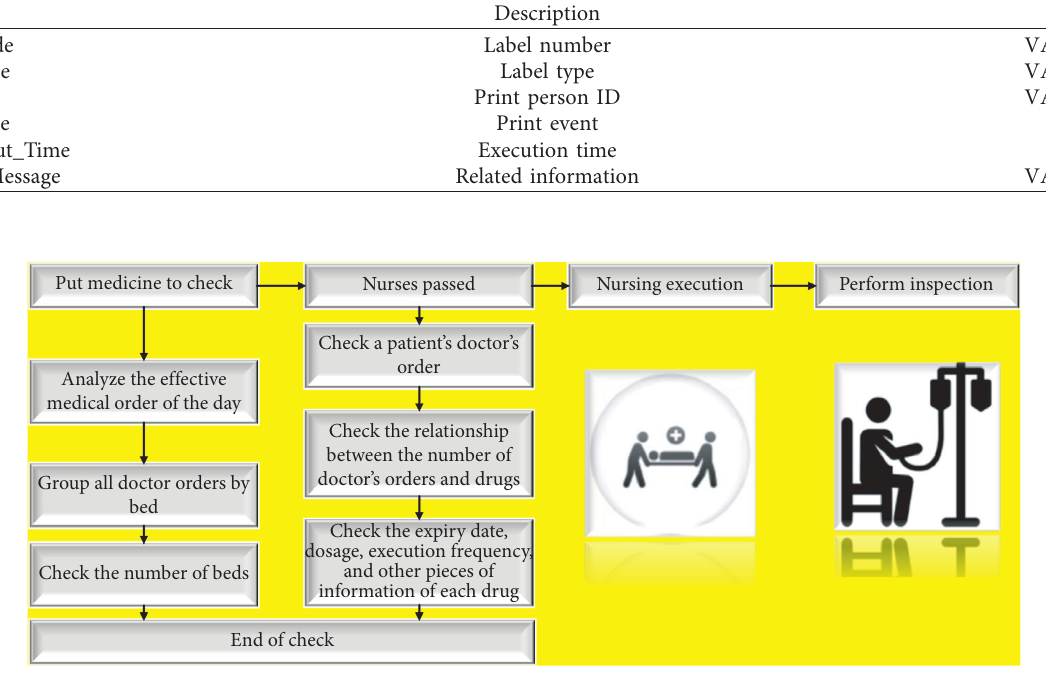
Figure 5: The process of nursing execution process management.